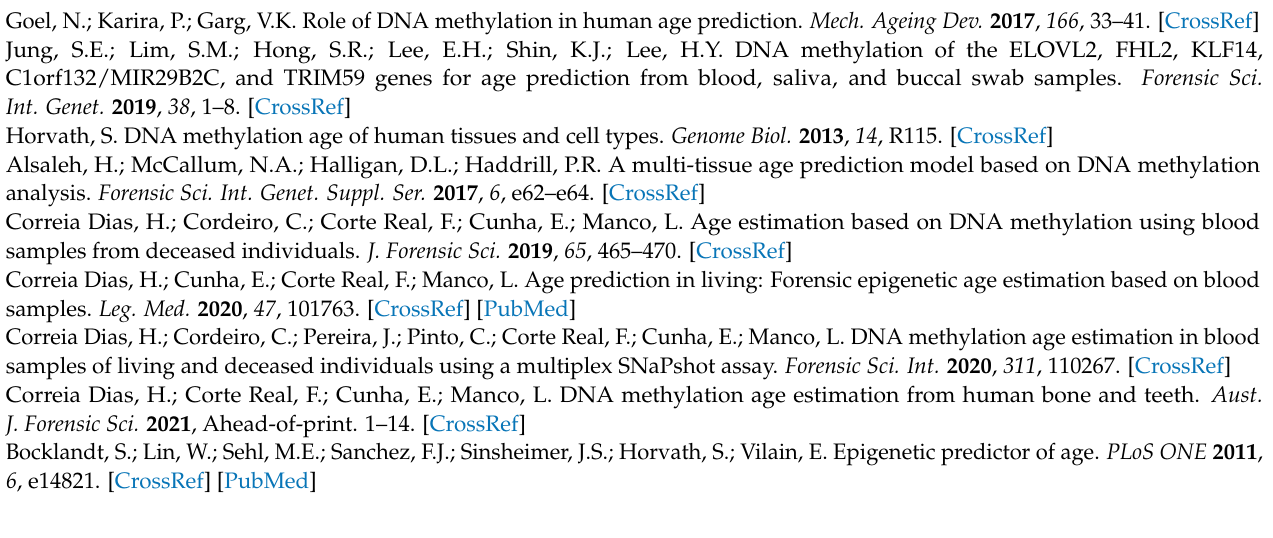
samples. Table S4: Statistical parameters obtained in a multiple regression model with the three CpGs in genes ELOVL2 , C1orf132 and KLF14 , selected by stepwise regression approach, in blood, bone and tooth